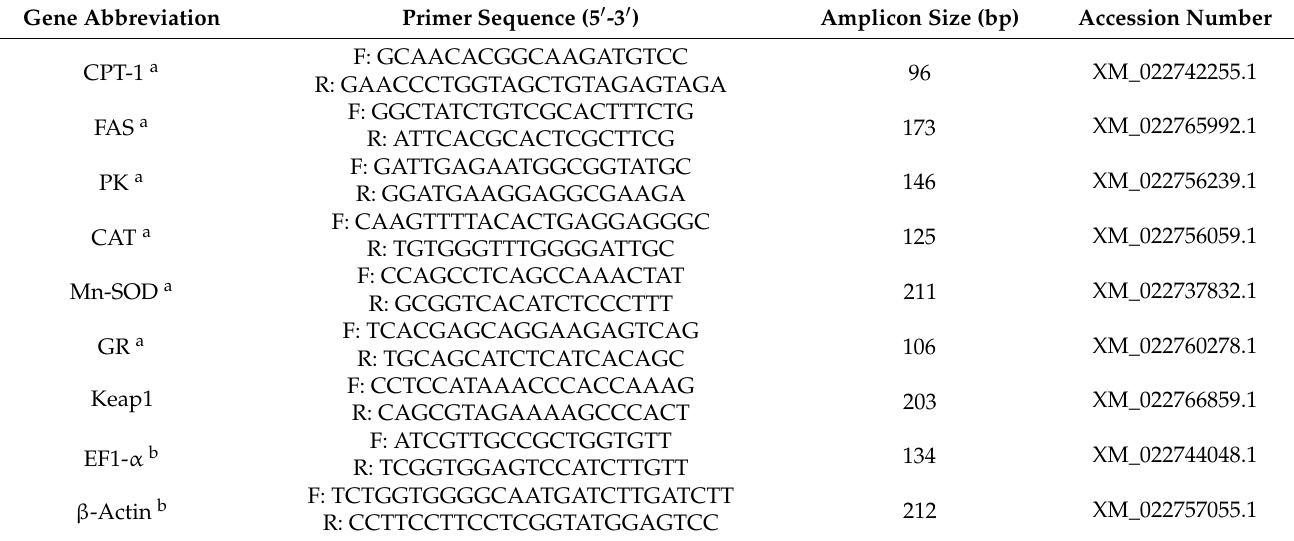
Table 1. Primers used for real-time